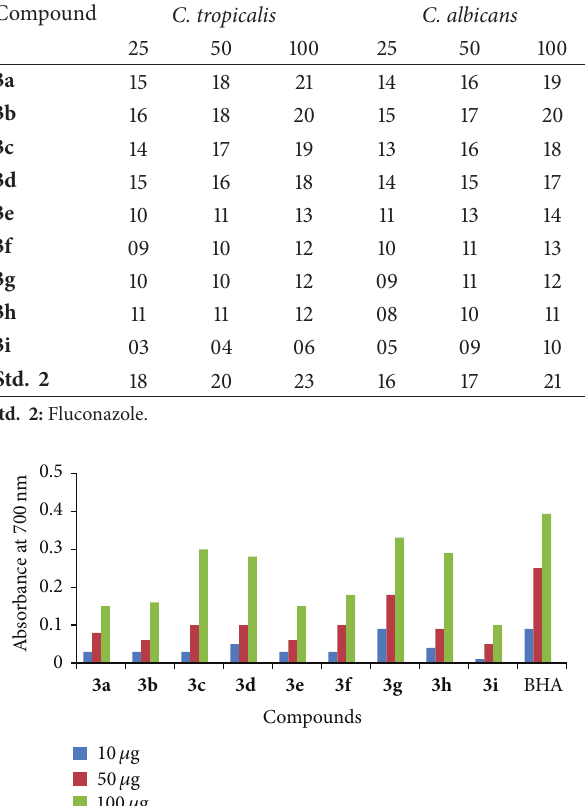
Table 3: Antifungal activity of synthesized compounds 3a–i (zone of inhibition in mm).